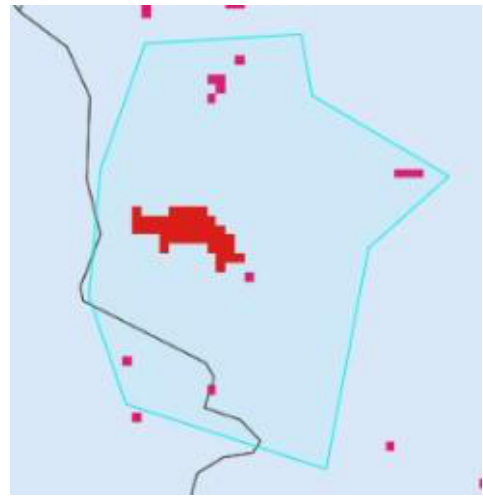
Figure 5. A settlement cluster (cluster boundary: cyan; a settlement cluster: red patch).